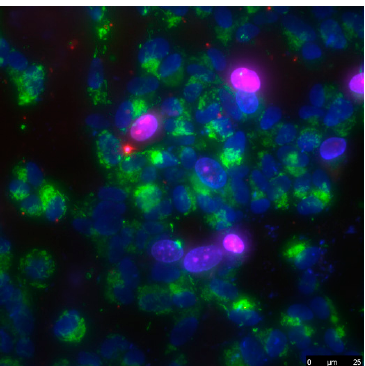
Figure 1. The sample of cell culture micrograph. The mitochondria of the cells are colored green; they can be used to estimate the size of the cells. Normal cell nuclei are colored blue. Nuclei of non-viable cells are stained in purple.